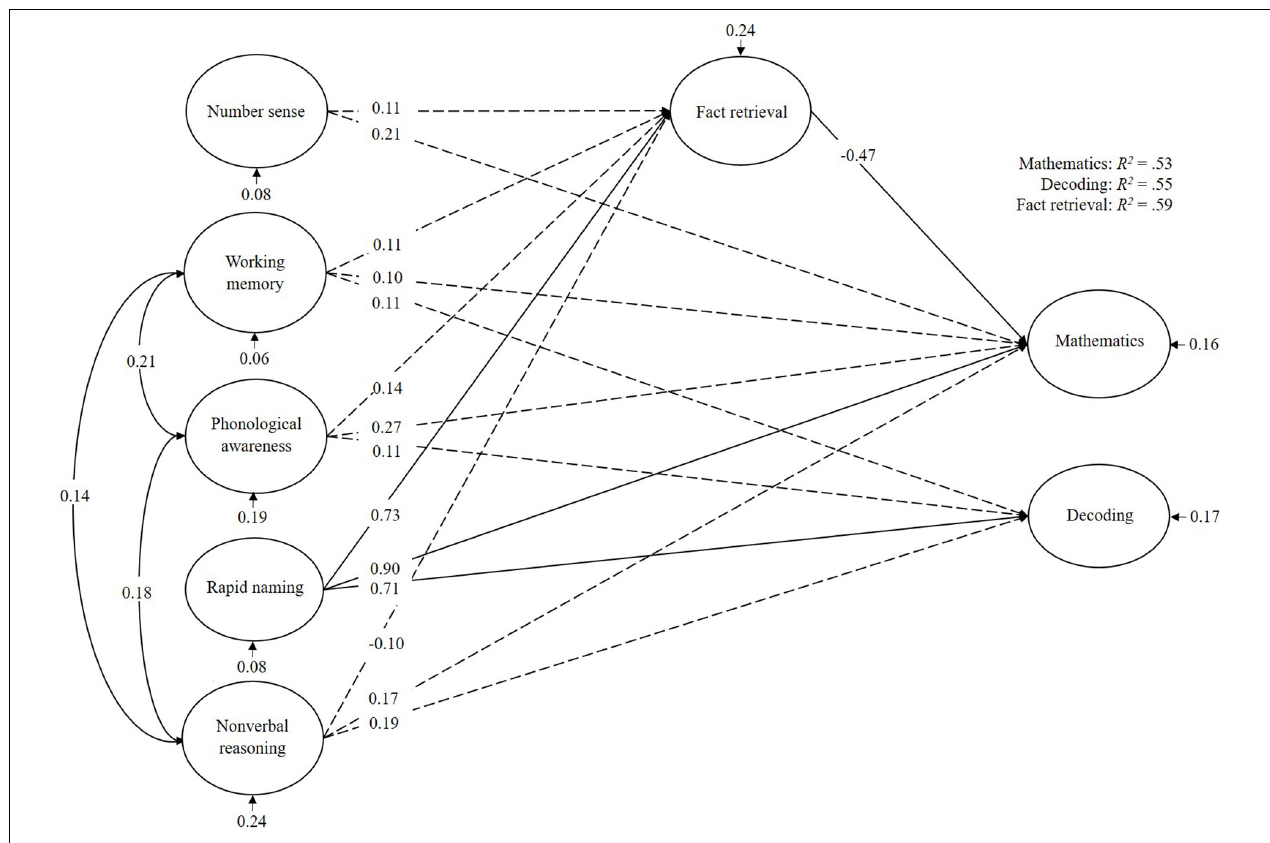
FIGURE 3 | Bayesian structural equation model for children with weak math abilities (MLD). Denoted values are beta